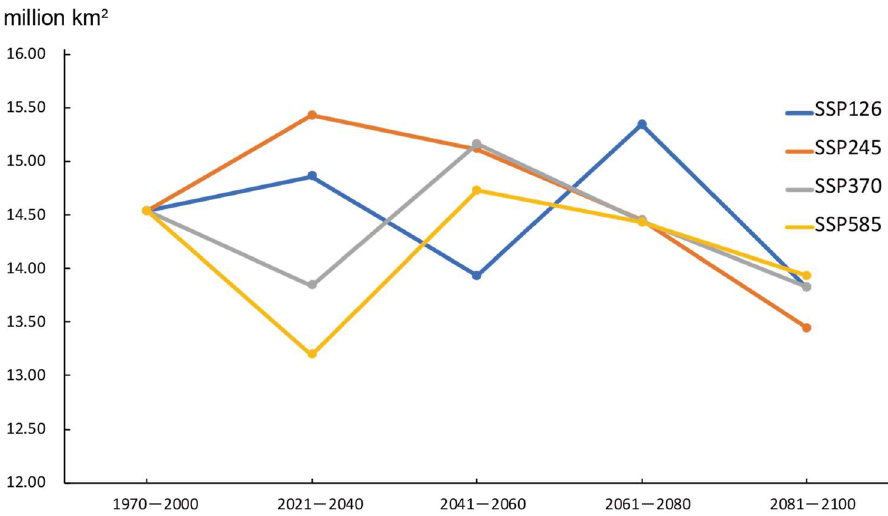
Figure 6. Variation trend of the amount of potentially suitable area.